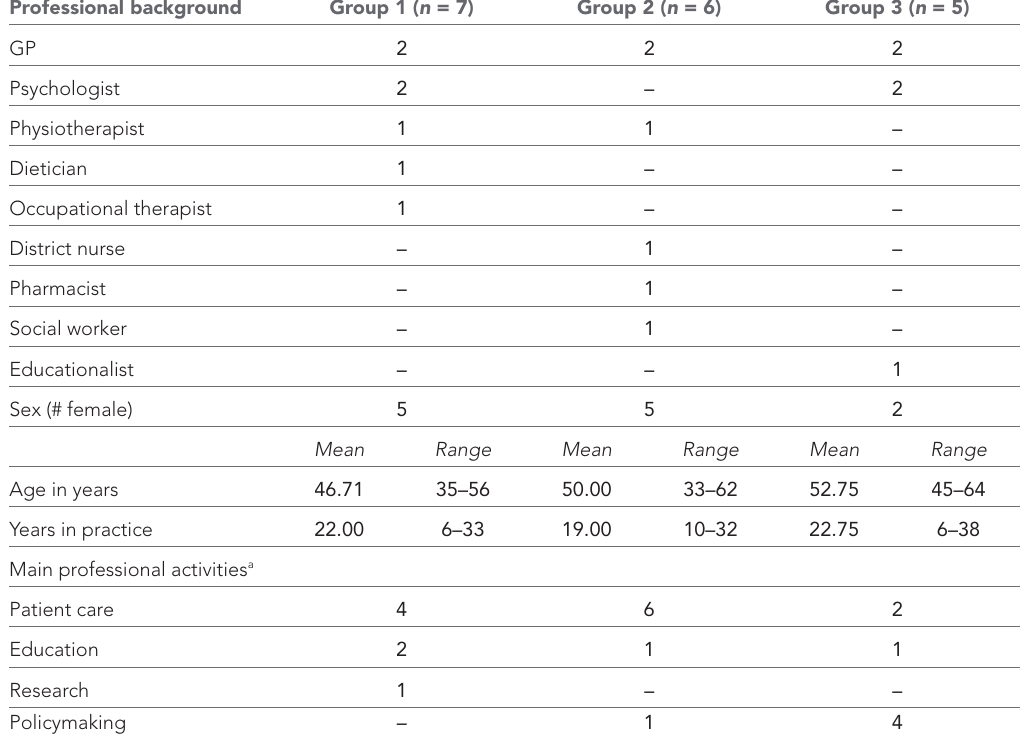
Table 1 Participant characteristics and group